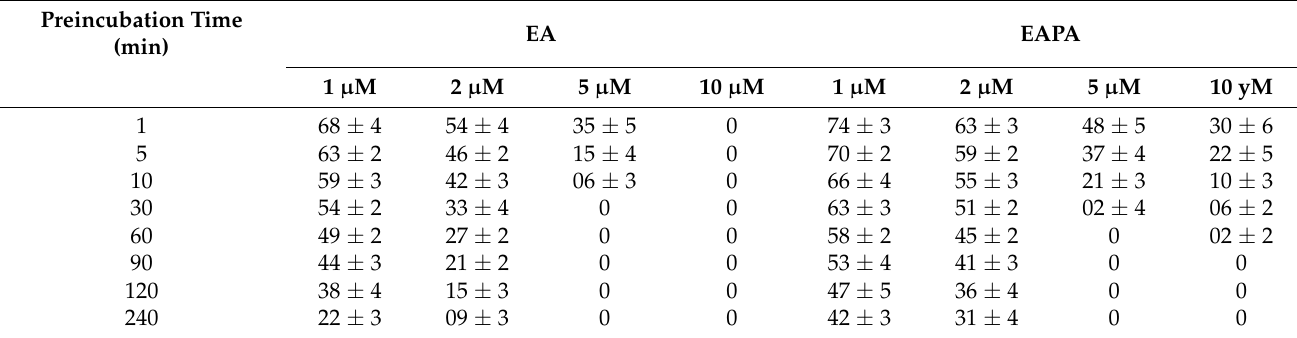
Table 2. Kinetics of decay of the galvinoxyl EPR signal remaining after incubation of 10 µ M glavinoxyl with EA and EAPA a . Preincubation